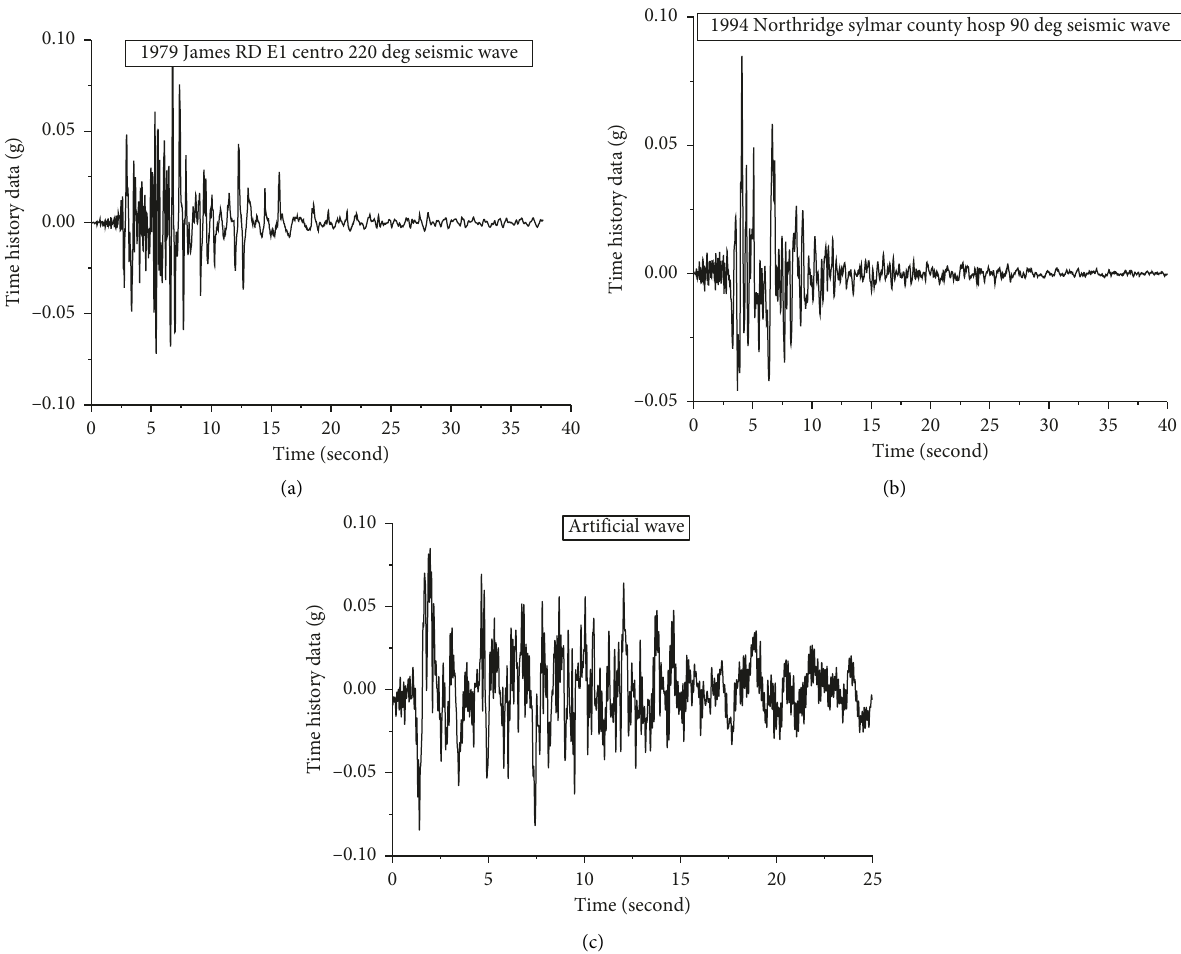
Figure 4: Time-history functions of three kinds of seismic waves after adjustment. (a) 1979 James RD E1 Centro 220 Deg, (b) 1994 Northridge Sylmar County Hosp 90 Deg, and (c) artificial